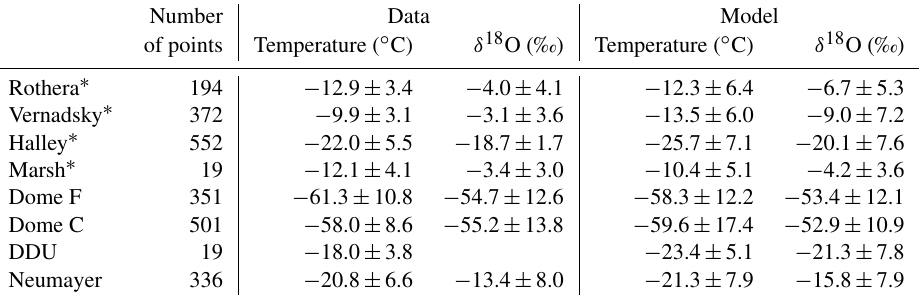
Table 3. Comparison between measurements from precipitation samples and ECHAM5-wiso simulated precipitation isotopic composition for grid cells closest to the sampling locations over the same period as the data (at daily or monthly scale when the name of the station is associated with an asterisk). We report the mean value ± the standard deviation for δ 18 O (in ‰) and for temperature ( ◦